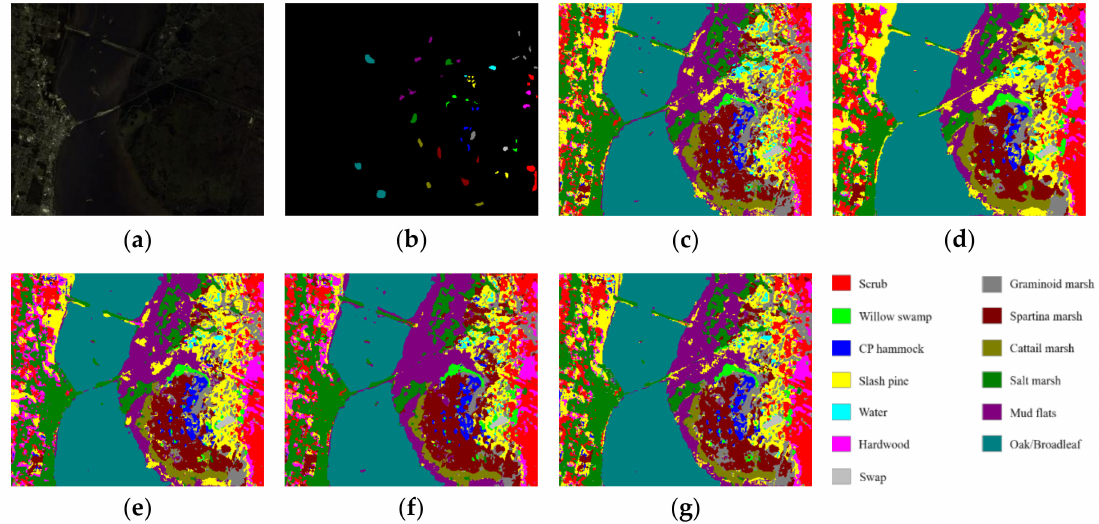
Figure 12. Classification results of the models in comparison with the KSC dataset. ( a ) False color